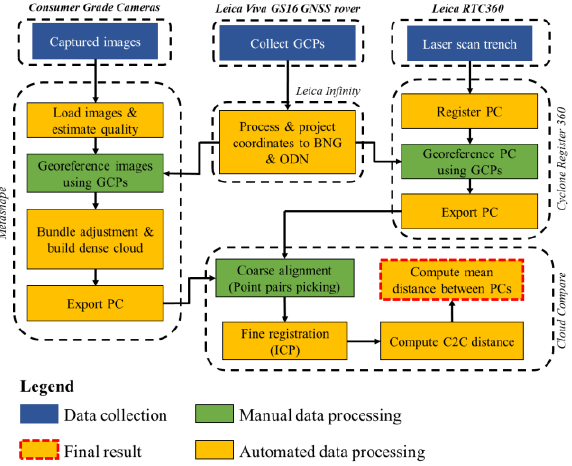
Figure 2 . Workflow for computing cloud-to-cloud distance.